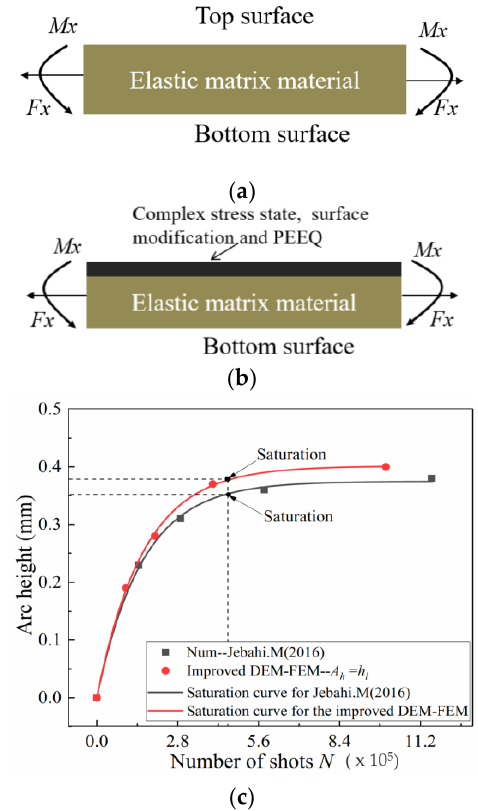
Figure 20. Influence of the plastic layer on deformation. ( a ) The elastic state used in the current equivalent method. ( b ) The plastic layer considered in the improved DEM-FEM. ( c ) Comparison of saturation curve for shot velocity: 50 m/s and S230 steel shot.